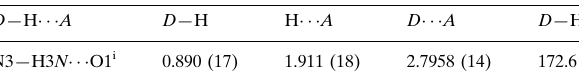
Hydrogen-bond geometry (A˚ , (cid:1)